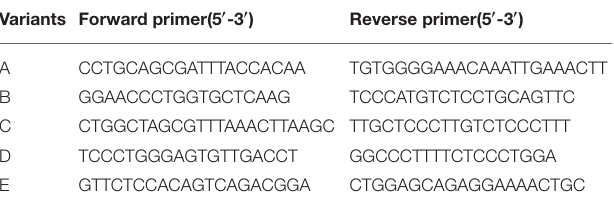
TABLE 1 | PCR primer